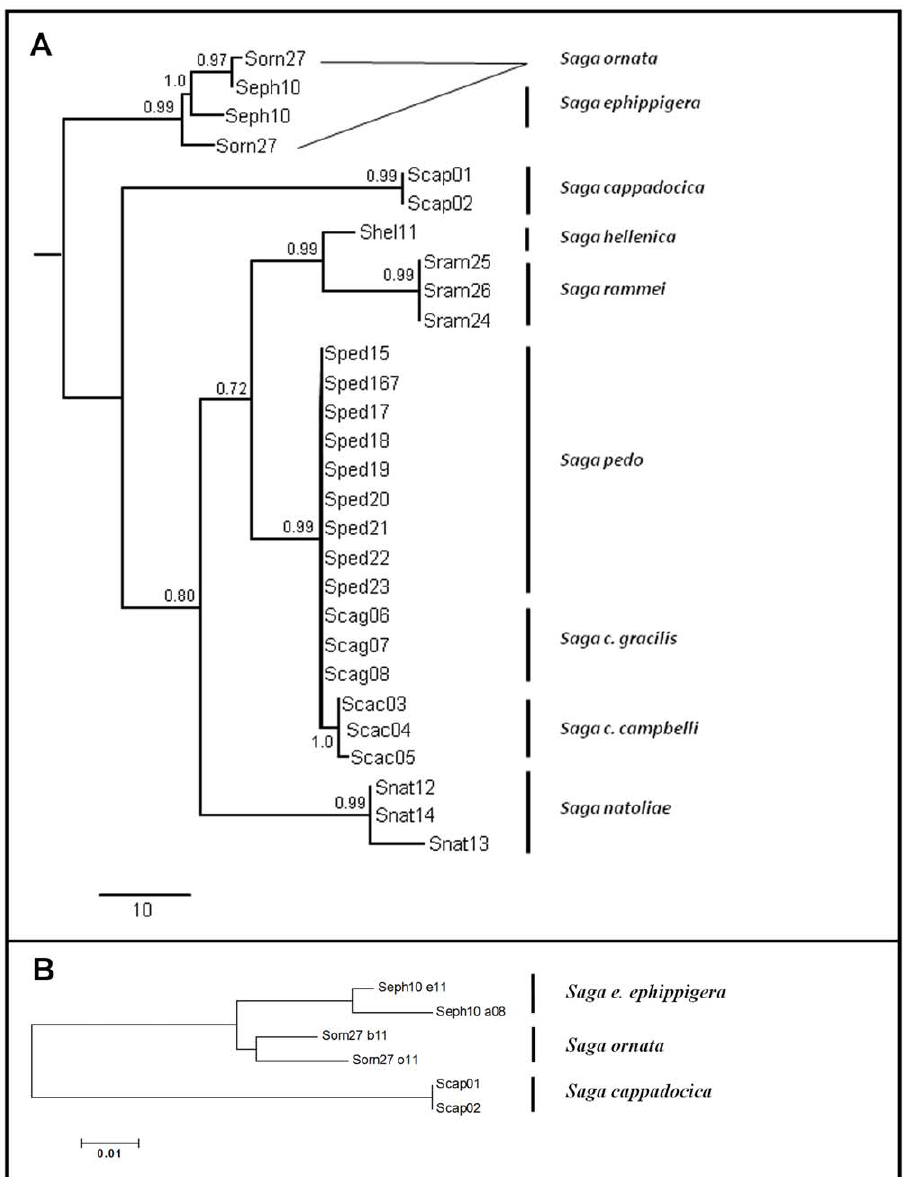
Figure 4. Evolutionary relationship of Saga species estimated from the nuclear DNA sequences. Panel A: Maximum Parsimony phylogenetic tree of Saginae based on ITS2 sequences. The consistency index was 0.91, whereas the retention index was 0.966 for MP tree. The composite index was 0.888 for all sites and 0.879 for the parsimony-informative sites. There were a total of 829 positions in the final dataset, out of which 95 were parsimony-informative. Vertical bars at right indicate the species. Bootstrap values are presented at each node. The unrooted tree showed the S. ephippigera-ornata clade as most basal group. The transient S. cappadocica is positioned between the Asian S. ephippigera-ornata and the European Saga linegae ( S. hellenica, S. rammei, S. pedo, S. c. gracilis, S. c. campbelli, S. natoliae ). Panel B:Asian Saga species have a long insertion in their ITS2 sequence, compared to that of European species. Evolutionary relationship of the ITS2 insertions is presented in a Neighbor-Joining tree. The tree is drawn to scale, with branch lengths in the same units as those of the evolutionary distances used to infer the phylogenetic tree. The evolutionary distances were computed using the Maximum Composite Likelihood method and are in the units of the number of base substitutions per site.